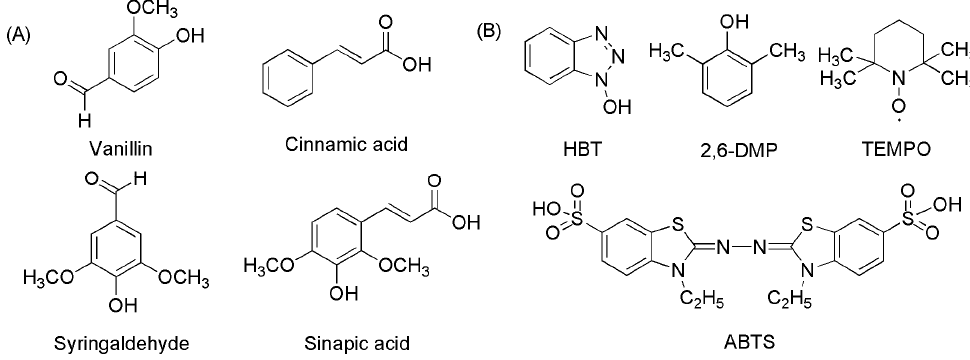
Figure 3. The chemical structures of several artificial and natural redox mediators in laccase-catalyzed oxidation reaction systems. ( A ) natural redox mediators; ( B ) artificial redox mediators.